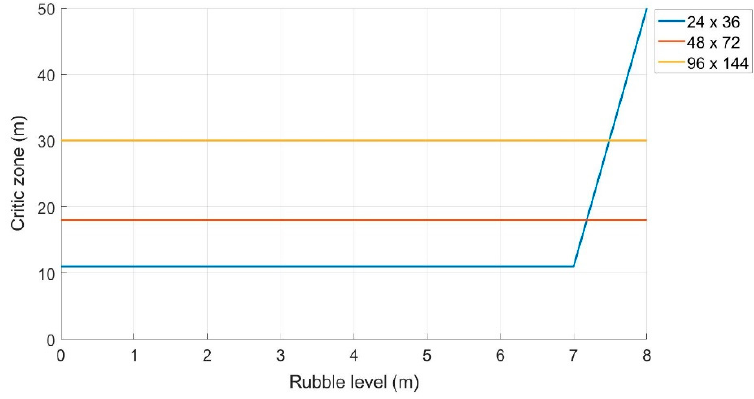
Figure 15. Variation of the “Critical Zone” as the amount of rubble increases.